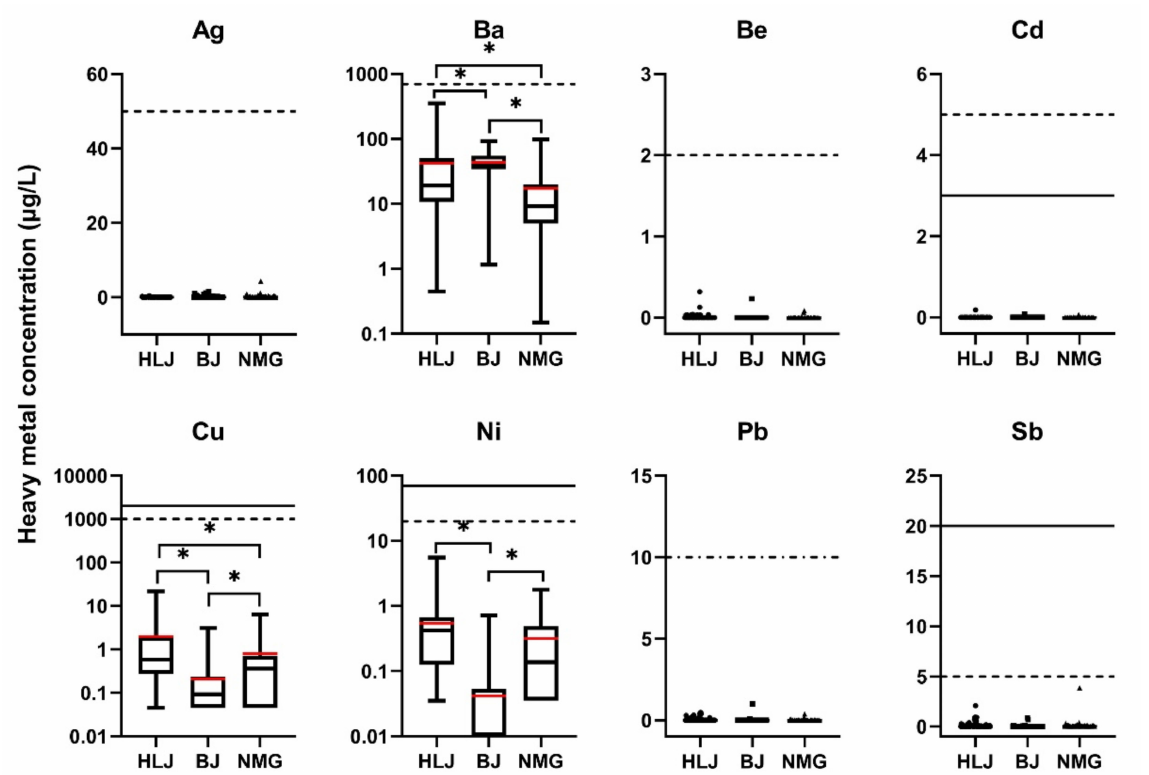
Figure 2. The concentrations of heavy metals in self-supplied wells water (elements mentioned and not exceeding in SDW or WHO). Straight line, WHO; dotted line, SDW; dash-dotted line, SDW and WHO have the same standards limits. The red line is the average value. * Represents p <